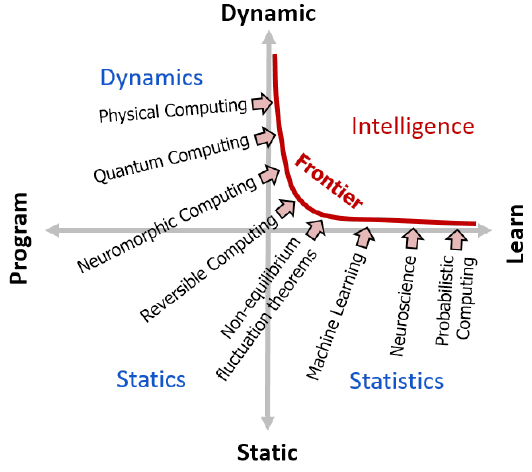
Figure 3. Intelligence stands at the frontier of our understanding, illustrated in the upper right corner of the same four domains used in Figures 1 and 2 . Multiple approaches with roots in the other quadrants address this frontier, but a comprehensive understanding is yet to be